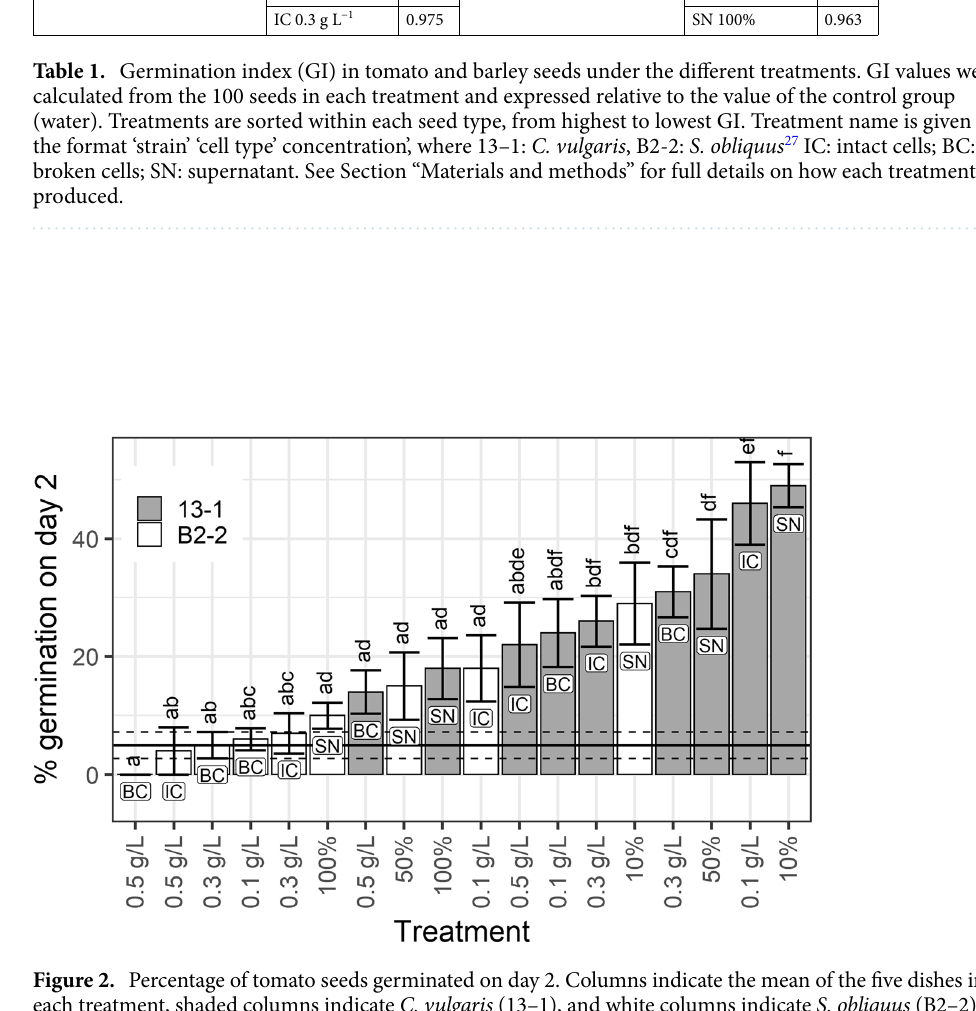
Figure 2. Percentage of tomato seeds germinated on day 2. Columns indicate the mean of the five dishes in each treatment, shaded columns indicate C. vulgaris (13–1), and white columns indicate S. obliquus (B2–2). Labels inside columns indicate the type of cell used for treatment. Letters above columns indicate group belonging, within which no significant difference at the 0.05 level could be found (one-way ANOVA with Tukey’s post hoc test). Mean of the control group is indicated by the horizontal filled line, and its group adherence is ‘ab’. Error bars indicate ± s.e.m. (control group ± s.e.m. is indicated by dashed horizontal